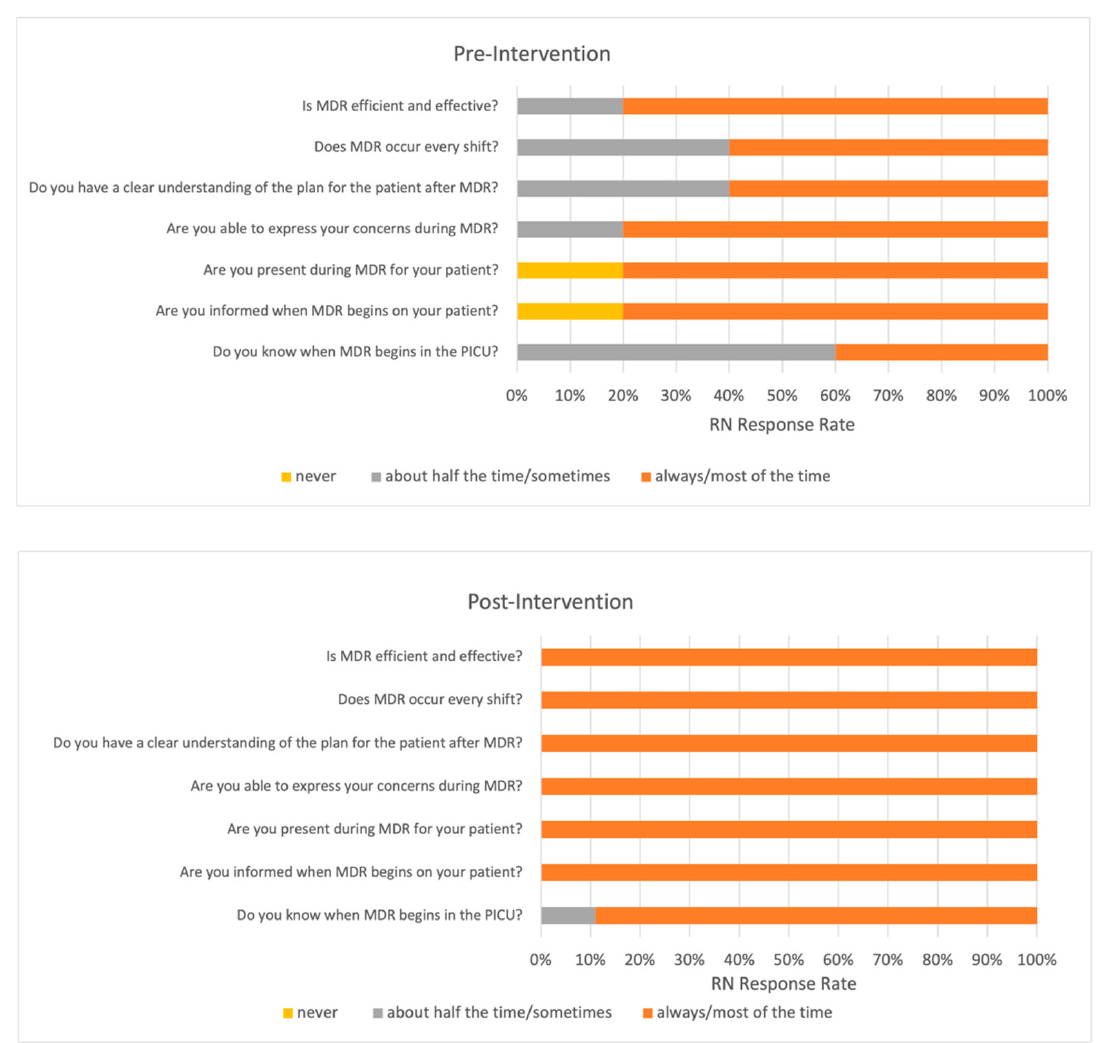
Figure 3. PICU Registered Nurse Survey Results. MDR = Multidisciplinary Rounds. A seven-question survey was distributed to bedside PICU RNs before and after our quality improvement initiative. Five out of thirteen RNs (38.5%) responded to the pre-intervention survey. Nine out of fourteen RNs (64.3%) responded to the post-intervention survey. PICU = Pediatric Intensive Care Unit. RN = Registered Nurse.